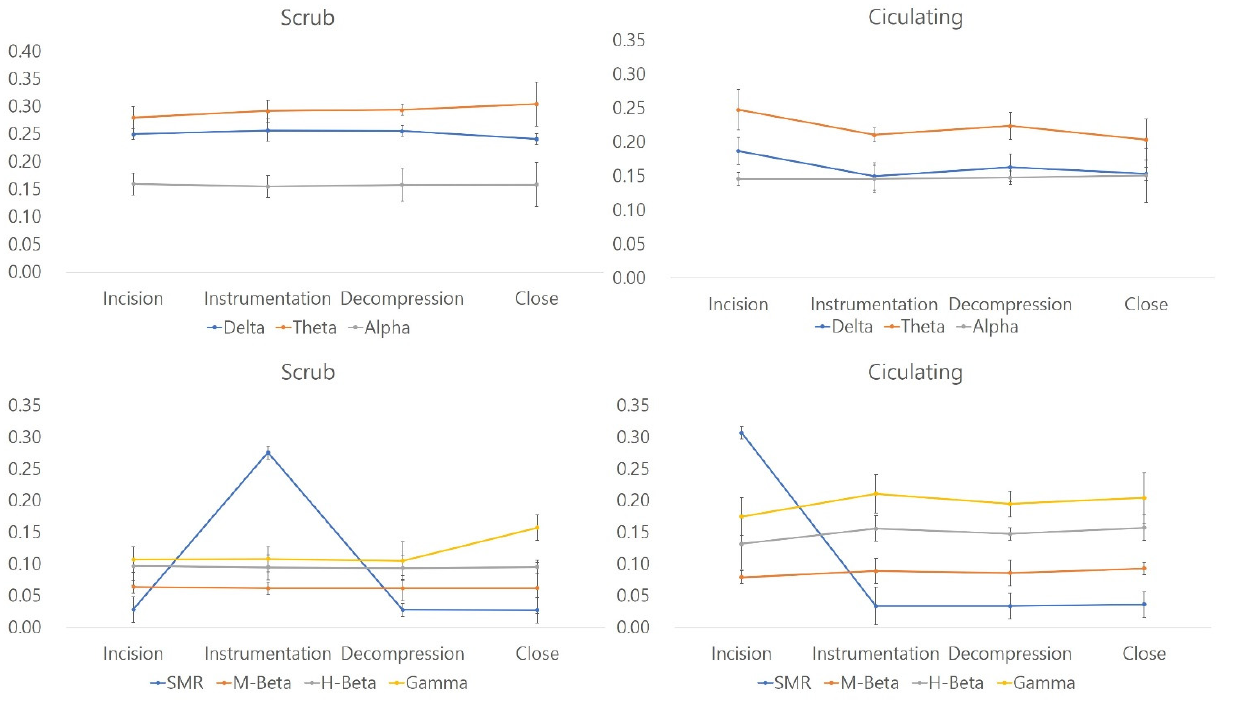
Figure 3. Analyses of EEG waves between scrub and circulating